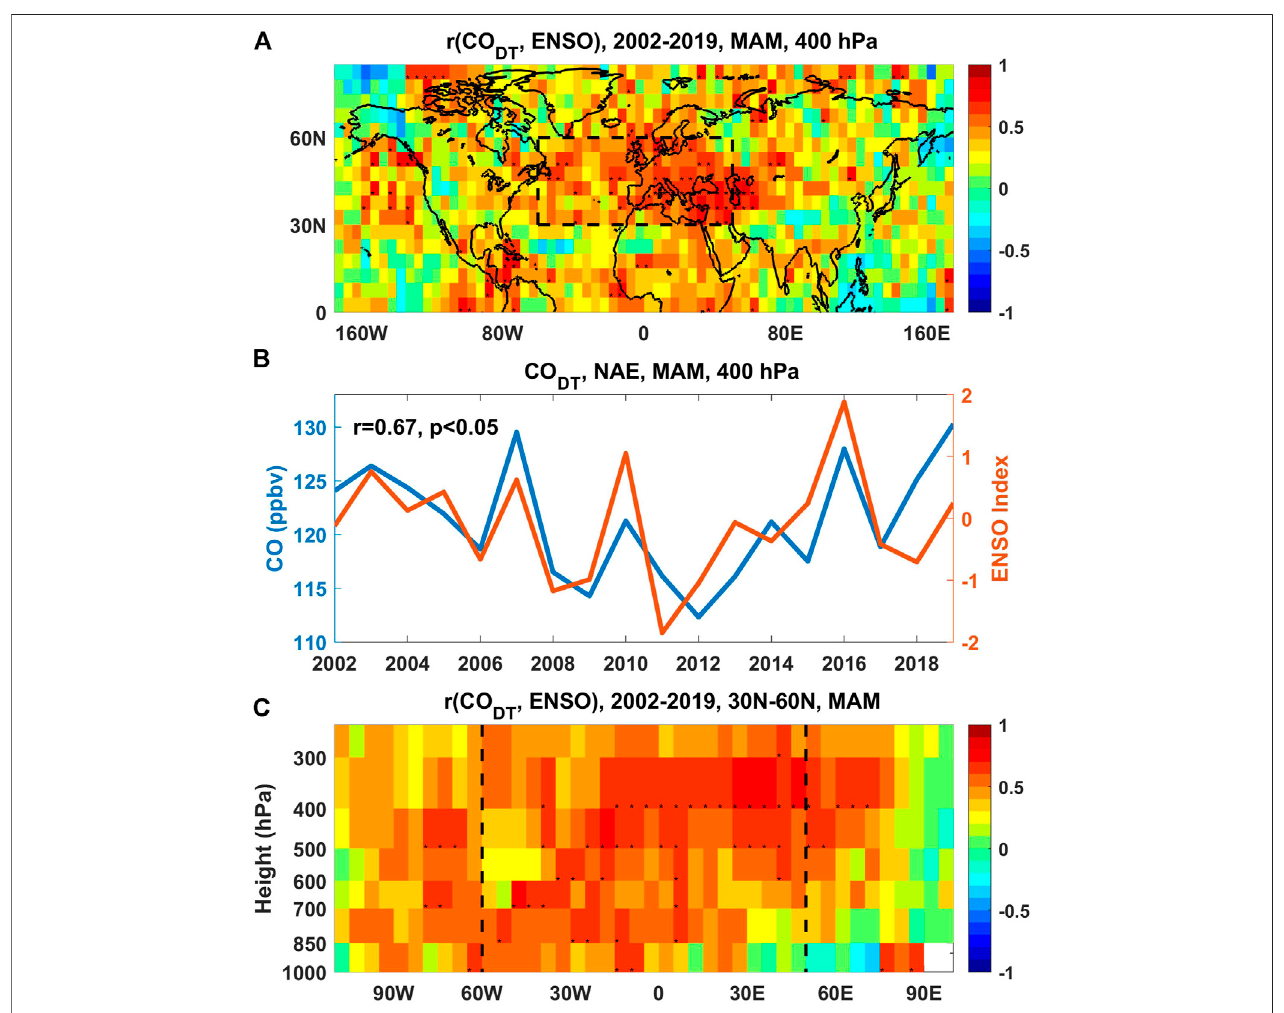
FIGURE 2 | (A) Correlation between the ENSO index and detrended CO concentrations (CO DT ) at 400 hPa in MAM over 2002 – 2019, with asterisks indicating correlations at the 95%signi fi cance level.The dashed lines indicate the area ofinterest, the NAE. (B) Interannualvariation in MAM CO DT (blue line) inthe NAE againstthe ENSO index in the previous winter (brown line, the mean of the ENSO index from November to February, the same in the fi gures and tables below). (C) The longitude- altitude cross section of the correlation between the ENSO index and MAM CO DT , averaged over 30 ° N-60 ° N, with asterisks indicating the 95% signi fi cance level. The vertical dashed lines show the longitudinal borders of the